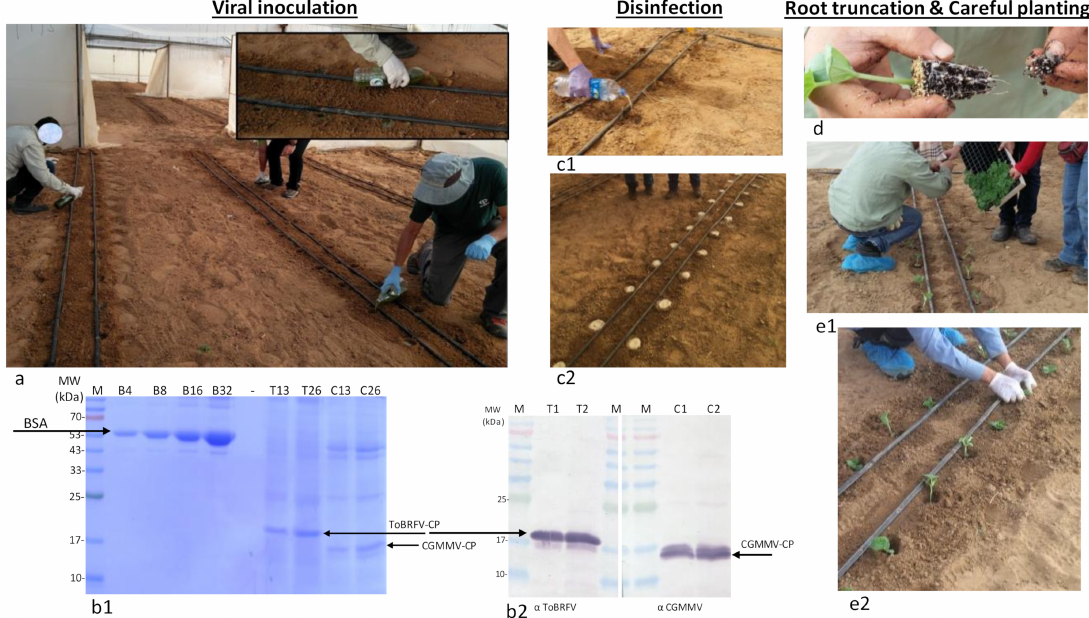
Figure 1. A platform for disinfectant efficacy tests in greenhouses: ( a ) a viral inoculum of ToBRFV or CGMMV infected leaves ground in 0.05 M sodium phosphate buffer pH = 7.0 at a concentration